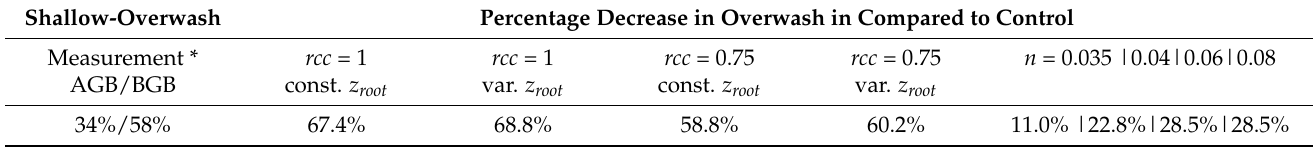
Table 5. Percentage decrease in overwash compared to the control cases for shallow overwash. Shallow-Overwash